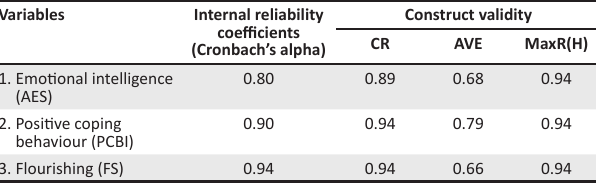
TABLE 3: Psychometric properties of the measurement instruments . Variables